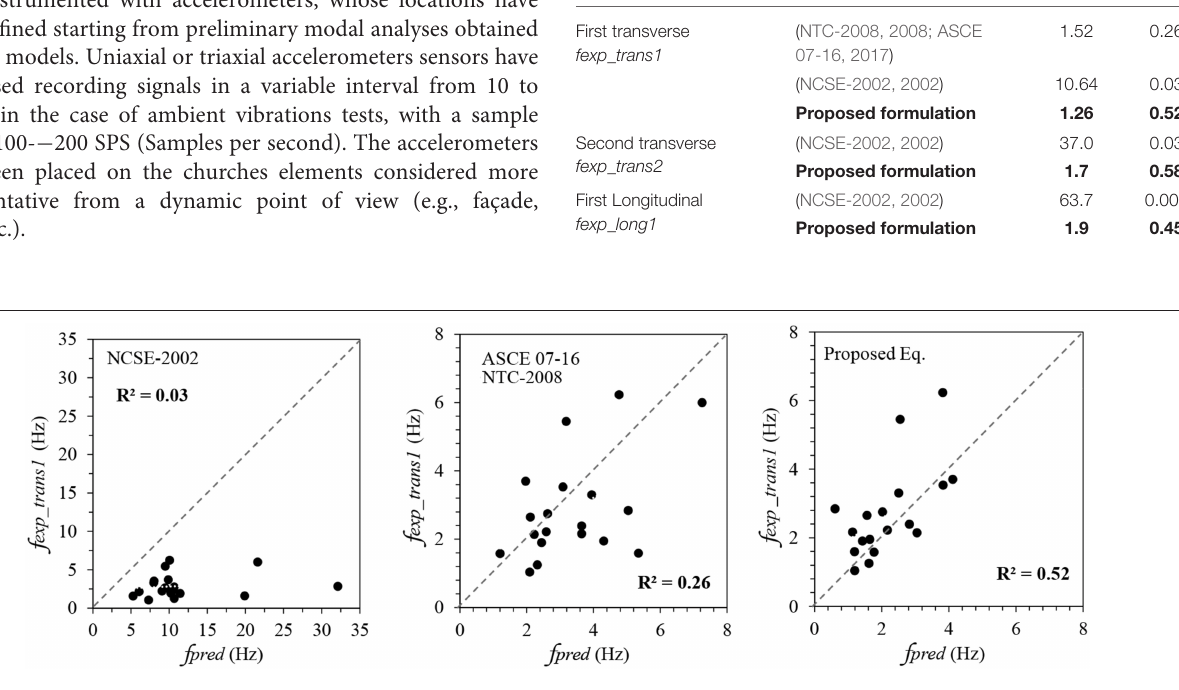
Frontiers in Built Environment |